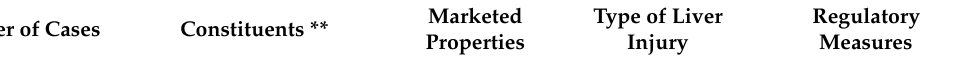
Table 1. Tabular compilation of dietary supplements related to liver